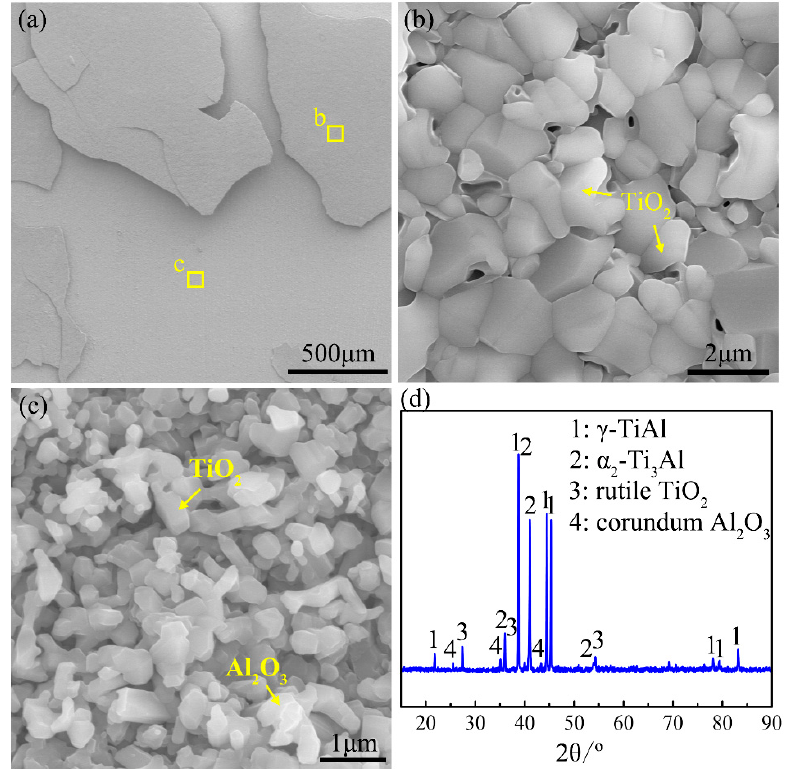
Figure 6. ( a – c ) Surface morphologies and ( d ) X-ray diffraction (XRD) pattern of the oxide formed during heating the Ti-46Al-2Cr-5Nb alloy to the end of Stage III.